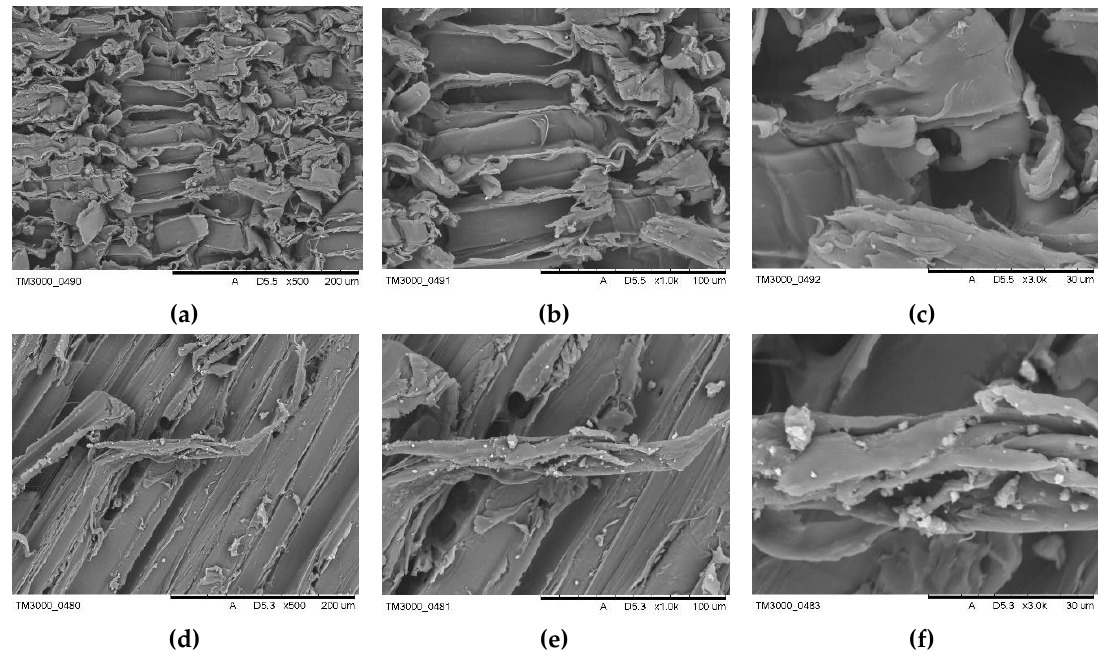
Figure 4. SEM images of raw sawdust at magnifications of ( a ) 500 × ; ( b ) 1000 × ; ( c ) 3000 × and modified sawdust at magnification of ( d ) 500 × ; ( e ) 1000 × ; ( f ) 3000 ×.